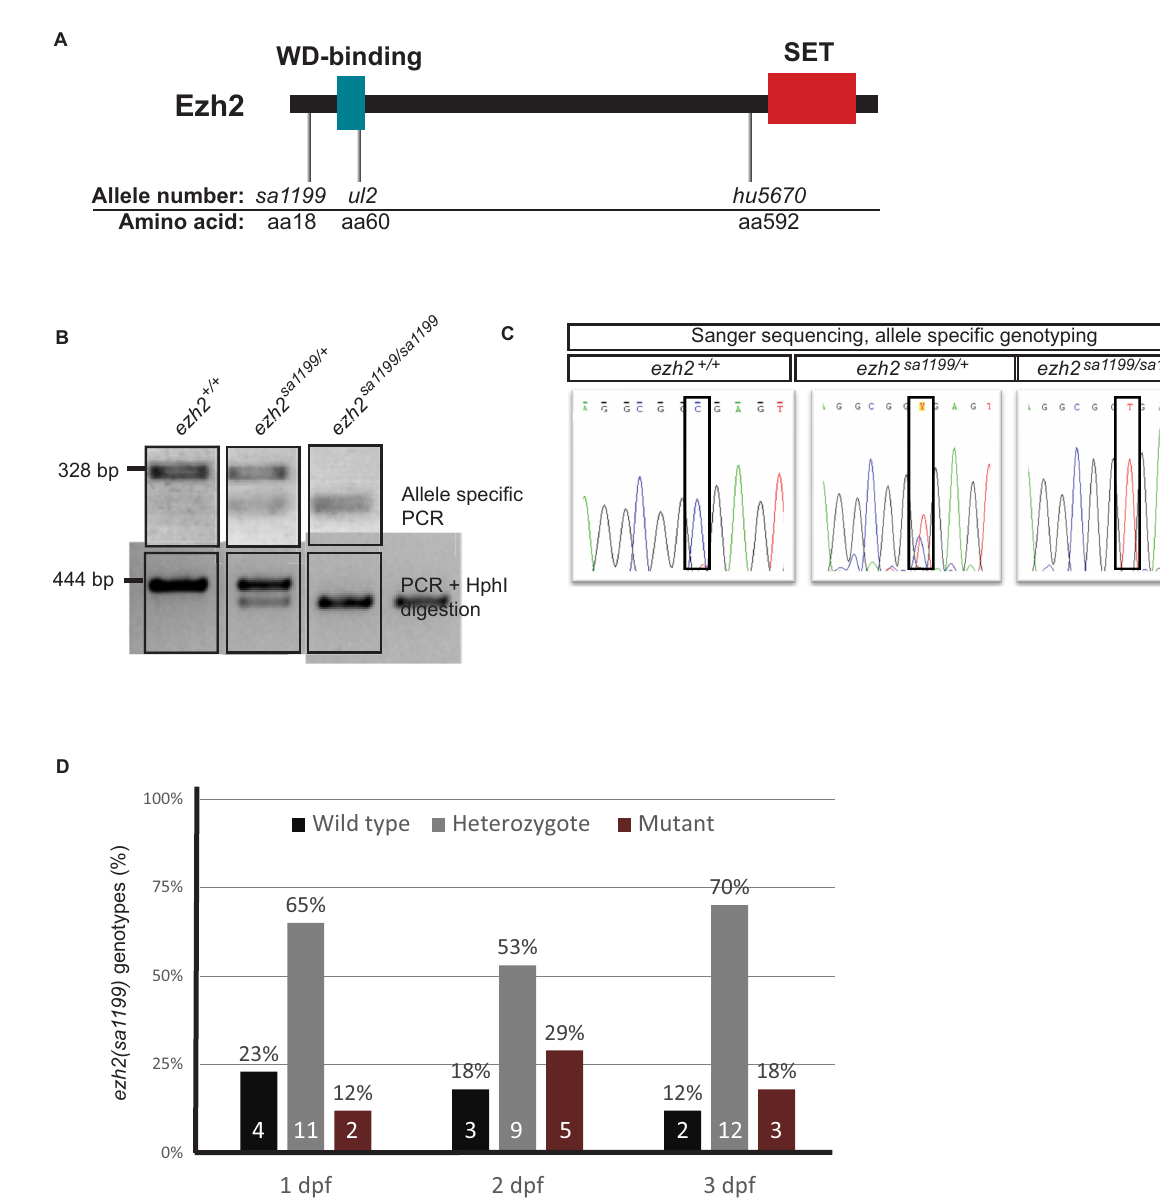
Fig 1. Validation of ezh2(sa1199) genotypes. A. Ezh2, its domains, and mutant allele positions (grey lines). The green and red boxes indicate WD-binding and SET domains, respectively. The ezh2(sa1199) allele (left) has a stop mutation on the arginine 18 position (R18STOP), ezh2(ul2) allele (middle) has a 22 bp insertion that leads to a nonsense codon at amino acid 60, and ezh2(hu5670) allele (right) has a nonsense mutation on the arginine 592 (R592STOP) position. B. Allele specific (top) and PCR-restriction (bottom) genotyping on caudal fin clips of 2 dpf embryos. Agarose gel electrophoresis shows differential amplification or restriction enzyme digestion of the alleles. A wild type, heterozygous, and mutant genotype from a single experiment is represented for each method. C. Allele-specific genotyping validation by Sanger sequencing. Two dpf embryo fin clips were allele-specifically genotyped and Sanger-sequenced to validate the genotyping method. The mutation locus (black box) is visualized for wild type (left), heterozygous (middle), and mutant (right) embryos. D. Allele specific genotyping of 1, 2, and 3 dpf ezh2(sa1199) in-crossed embryos (N = 17 per day). The percentage of wild types (black), heterozygotes (grey), and mutants (brown) show a Mendelian ratio. The number of embryos is indicated inside the bars of the graph in